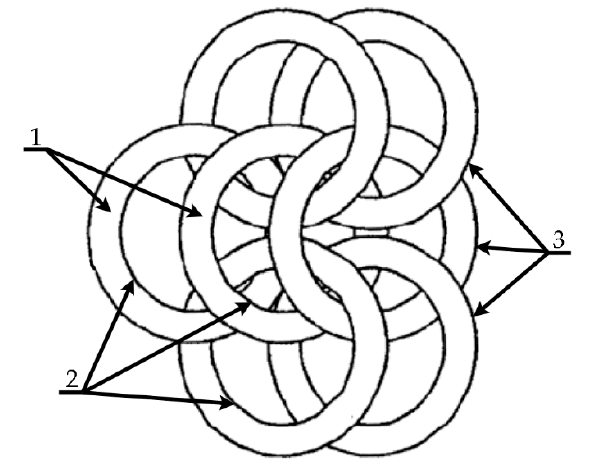
Figure 3. Example of additively manufactured cell interlacing: 1—cells forming the grid structure; 2—internal circuit of the adjacent grid structure element; 3—external circuit of the adjacent grid structure element.